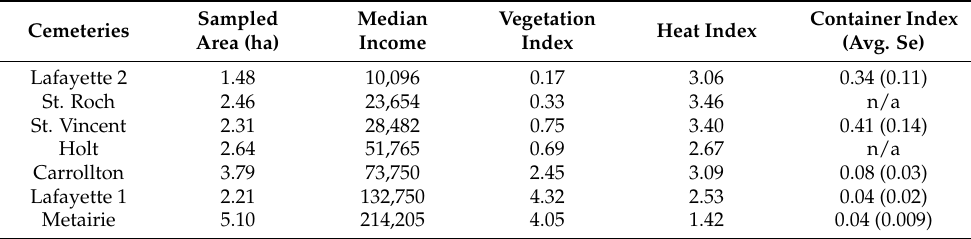
Table 1. Cemetery descriptive statistics (L) low classification, (H) high classification.